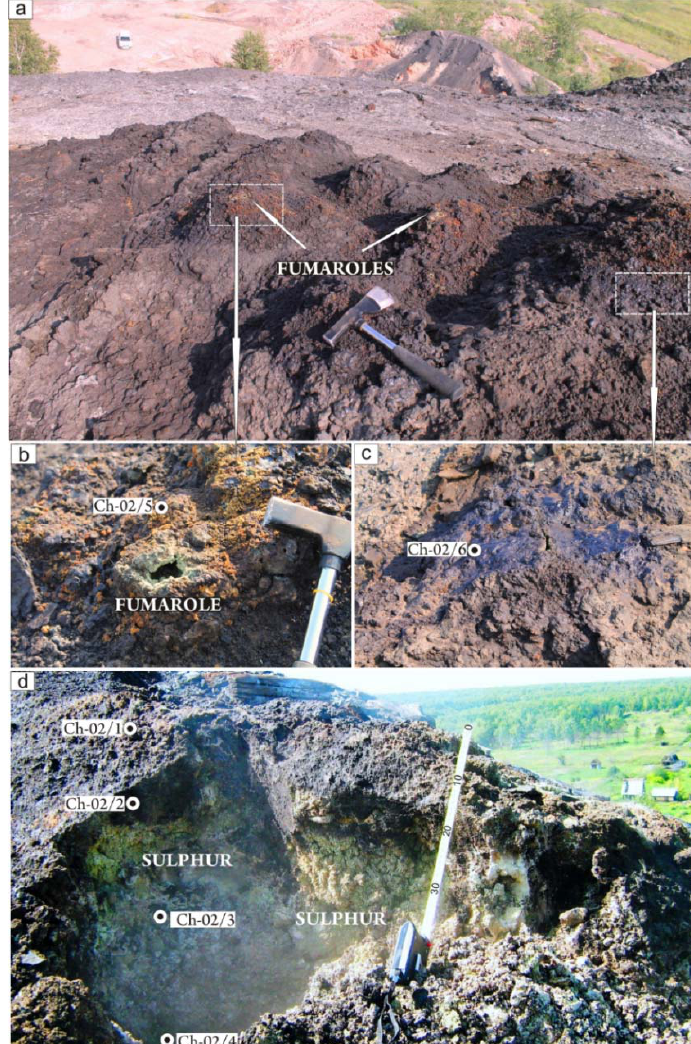
Figure 5. The main products of active fumaroles of spoil heap Ch-02: ( a ) a general view of the pyrolysis products and conical structures of active fumaroles; ( b ) a “crateral” part of fumaroles contoured by greenish-yellow authigenic sulphur; ( c ) oily resinous pyrolysis products; ( d ) a section of active pyrolysis fumarole, consisting of sulphur and hydrocarbon compounds, with an indication of sampling locations.